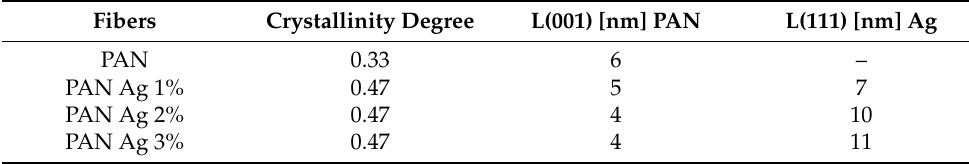
angle for the maximum peak [rad], λ is the length of the radiation beam 1.542 [Å], and β is the half-width of the peak [rad]. Table 1. Crystallinity degree of nanocomposite PAN fibers and size of